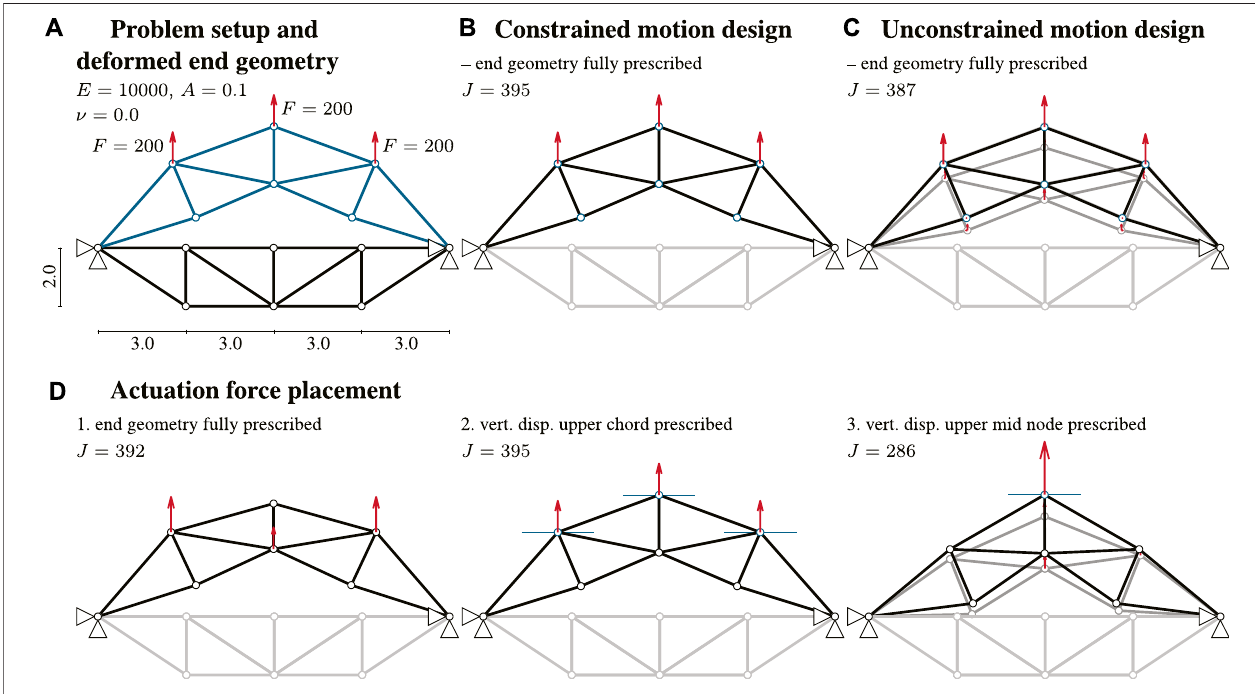
FIGURE 5 | In fl uence of the end-geometry on actuator placement. (A) Problem setup amd deformed end geometry. (B) Constrained motion design. (C) Unconstrained motion design. (D) Acuation force motion, 1) end geometry fully prescribed, 2) vert. disp. upper chord prescribed, and 3) vert. disp. upper mid node